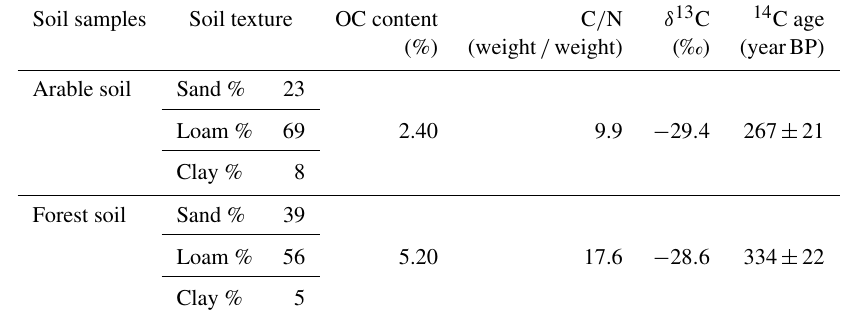
Table 3. Characteristics of the two soils used in this study. Texture was determined using laser diffraction (Coulter LS 13 320). Soil samples Soil texture OC